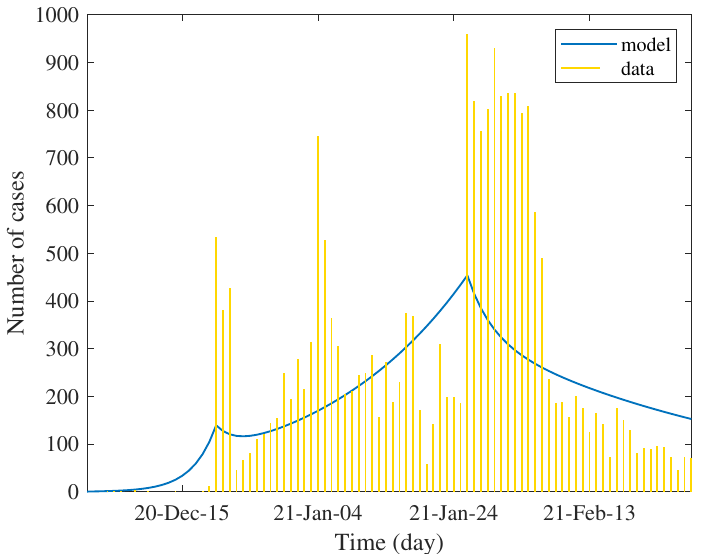
Figure 3. Curve fitting for daily case reports in the second wave. Small bars represent the data and solid lines present the